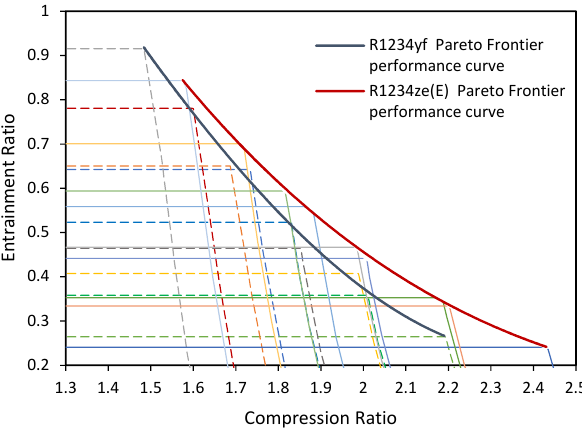
Figure 11. Pareto Frontier performance curve for all operation cases of the ejector based on CFD data.